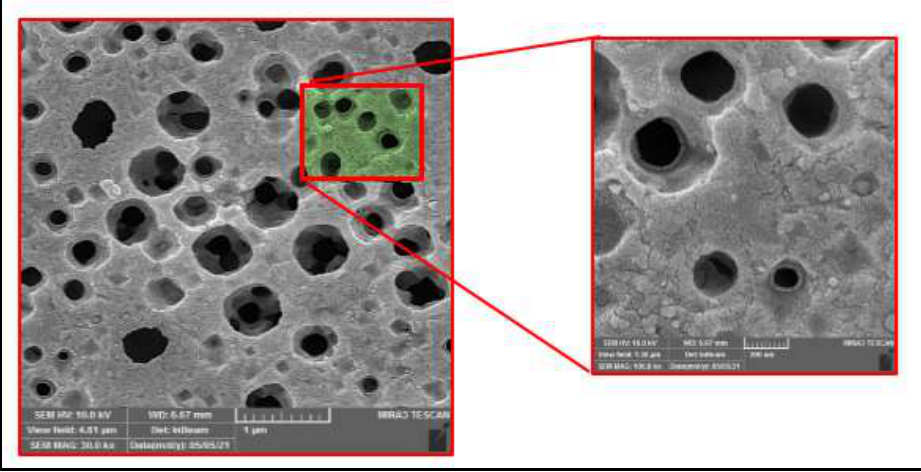
Fig.7a . SEM images of porous silicon samples were prepared with an etching time of (8mins.) at a current density of 14 mA/cm 2 .